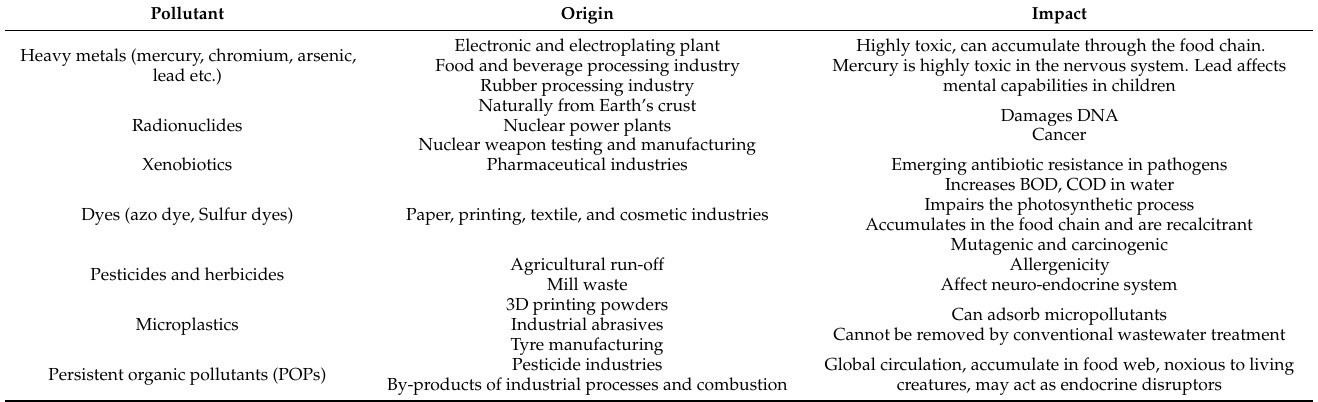
Table 1. Summary of pollutants in water, their origins, and their